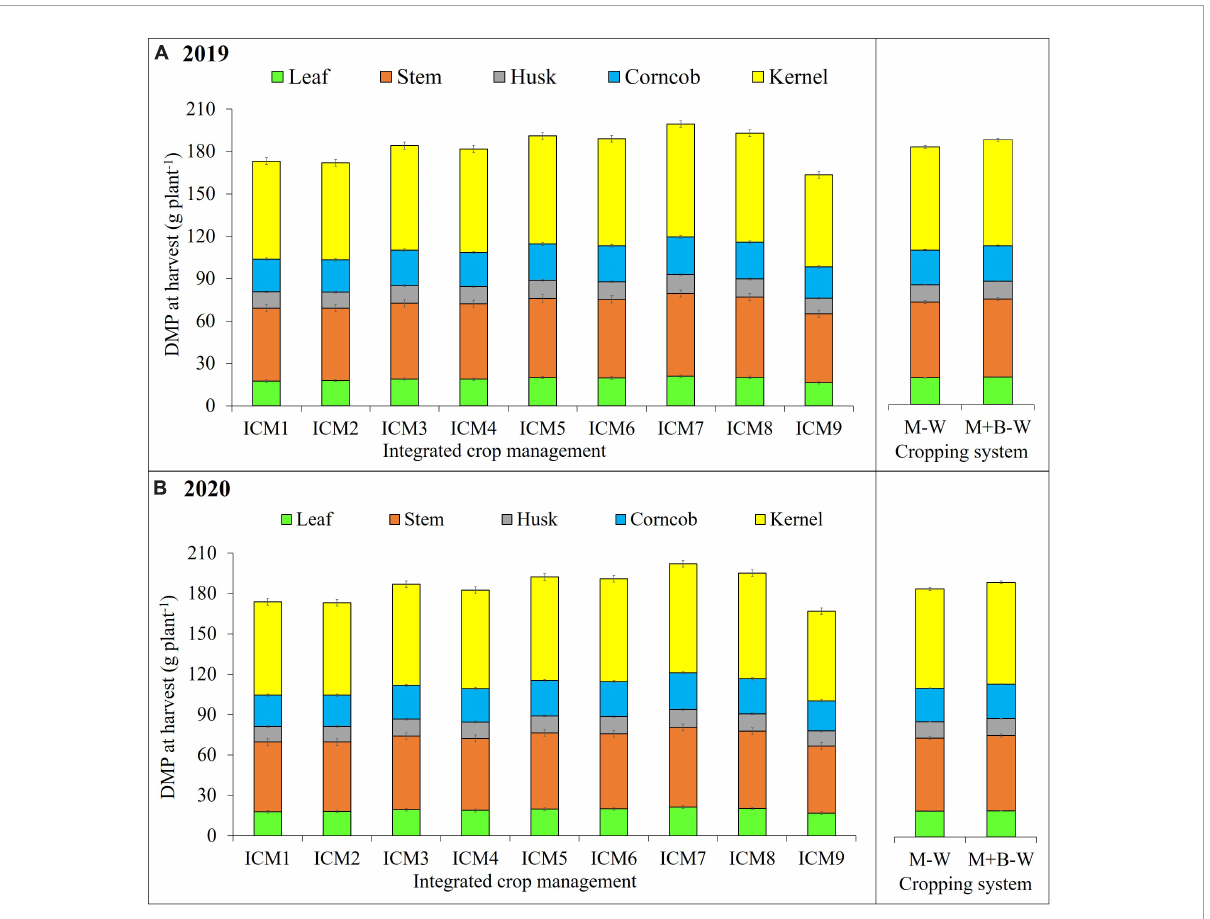
FIGURE3 Effect of different ICM modules and cropping system on dry matter partitioning (DMP) of maize at harvest 2019 (A) and 2020 (B) . The LSD 0 . 05 is indicated by a bar above each column, and any treatment difference beyond the range of bar within each year is significantly